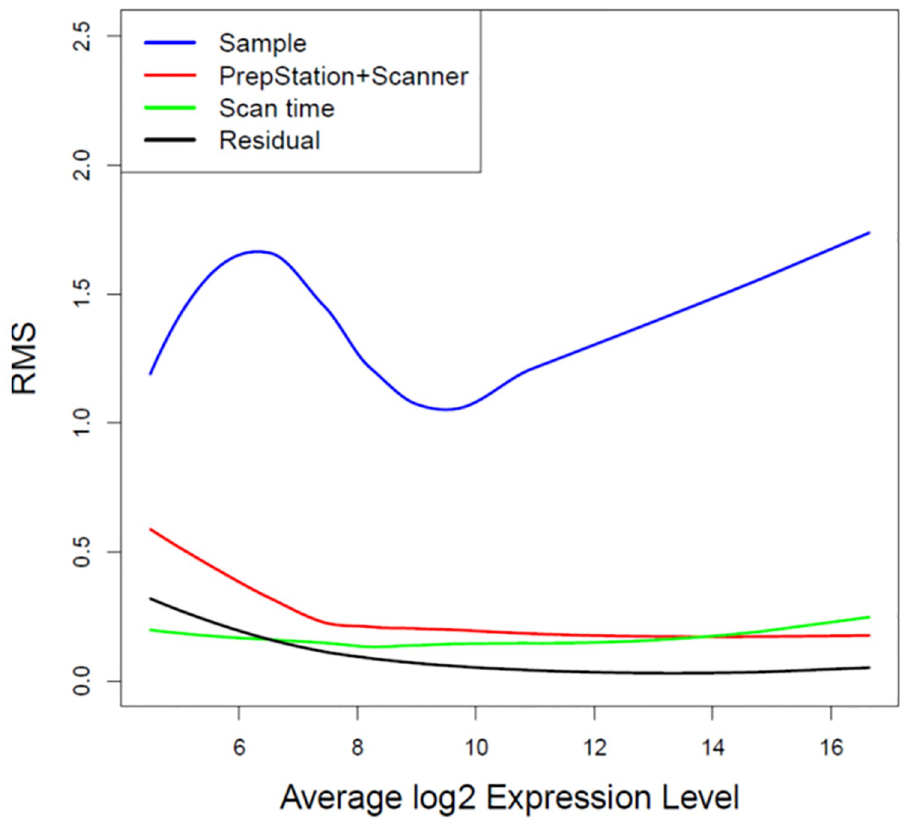
Fig 5. LOESS curve fitting of RMS against average expression levels for the comparison across both time scans. Variance components of ANOVA models were smoothed over average log2 expression levels through the LOESS fit. Blue curve represents variability of biological samples. Red curve represents variability of PrepStation and scanners. Green curve represents variability of scan times. Black curve represents variability of residual errors.